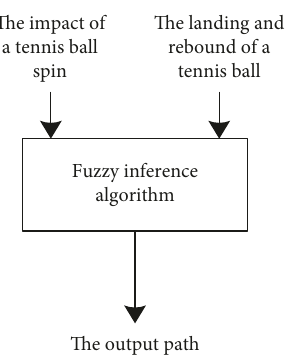
Figure 2: Fuzzy inference